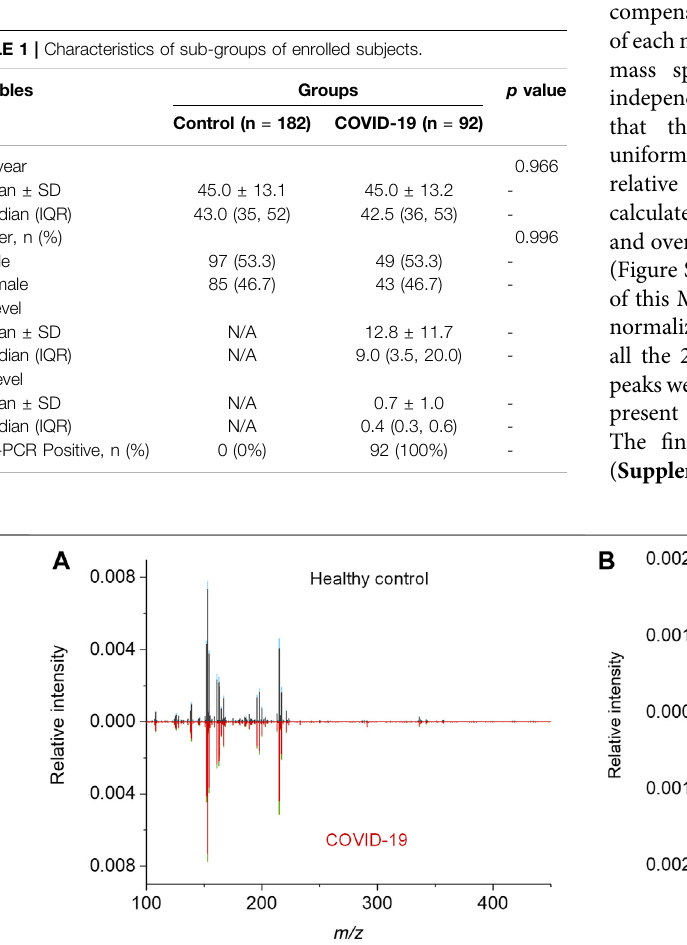
FIGURE 2 | MALDI MS metabolic patterns of control and asymptomatic COVID-19 patient samples. (A,B) Mean MALDI mass spectra and the respective interquartile range (IQR) obtained from healthy control and asymptomatic COVID-19 groups in the mass range of (A) 100 – 450 Da and (B) 450 – 1,000 Da, respectively. The IQR were denoted by blue and green for the healthy control and patient groups,